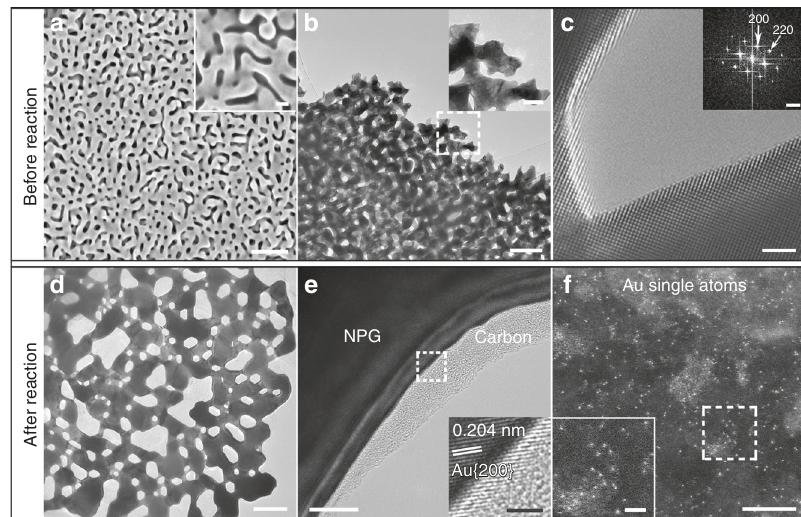
Fig. 1 Characterization of NPG before and after the ex situ catalytic CH 4 pyrolysis reaction. SEM ( a ) and TEM ( b ) images of an NPG sample before the reaction. The insets in a and b are a high-magni fi cation SEM image and the close-up view of the boxed region in b , respectively. c HRTEM image and its fast Fourier transform pattern. TEM ( d ) and HRTEM ( e ) images of an NPG sample after the reaction. f HAADF image of a carbon region on the NPG sample. The insets in e and f are the close-up views of the boxed regions in e and f , respectively. Scale bars: a 200 nm; the inset of a 50 nm; b 200 nm; the inset of b 50 nm; c 2 nm; the inset of c 5 nm − 1 ; d 200 nm; e 10 nm; the inset of e 2 nm; f 5 nm; the inset of f 2